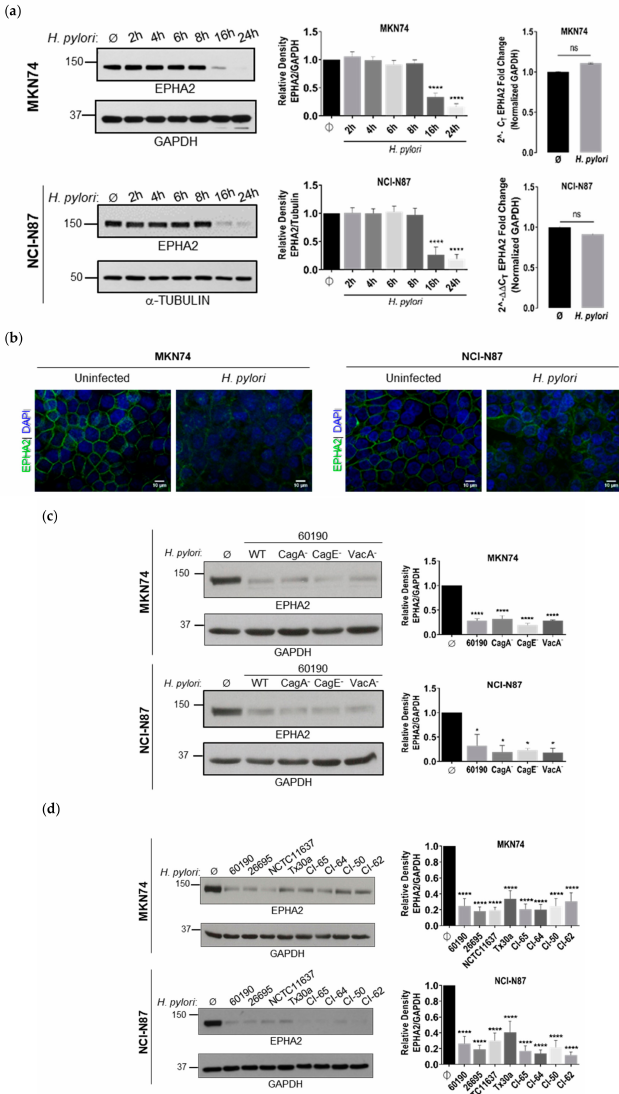
Figure 1. Prolonged exposure of gastric epithelial cell lines to H. pylori infection induced downregulation of EPHA2 receptor protein without a ff ecting mRNA levels independently of the major virulence factors T4SS, CagA, and VacA. ( a ) EPHA2 protein expression in MKN74 ( n = 5) and NCI-N87 ( n = 4) cell lines either uninfected (Ø) or infected with H. pylori 60190 for di ff erent periods of time at an MOI of 100 assessed by Western blotting with corresponding densitometric analysis (left and middle panels); EPHA2 mRNA levels assessed by RT-qPCR at 24 h post-infection ( n = 4; right panel); **** p < 0.0001; ns—not significant ( p > 0.05). ( b ) Immunofluorescence of EPHA2 (green) protein in MKN24 cells at 24 h post-infection, with nuclei stained with DAPI (blue) (scale bar: 10 µ m; 63 × original magnification; n = 3). ( c and d ) EPHA2 protein expression upon coculture with ( c ) wild-type or mutants ( cagE negative, cagA negative, vacA negative) of the H . pylori 60190 strain ( n = 5 for MKN74 and n = 2 for NCI-N87) and ( d ) with H. pylori reference strains (60190, 26695, NCTC11637, Tx30a) and clinical isolates (CI-65, CI-64, CI-50, CI-62) (n = 4 for each cell line) in 24 h cocultures at MOI100 assessed by immunoblotting; **** p < 0.0001; * p ≤ 0.05. The represented densitometric analysis are the mean ± SE of all independent experiments. One-way ANOVA with post-hoc Dunnett’s test for multiple comparisons and Student’s t-test for single